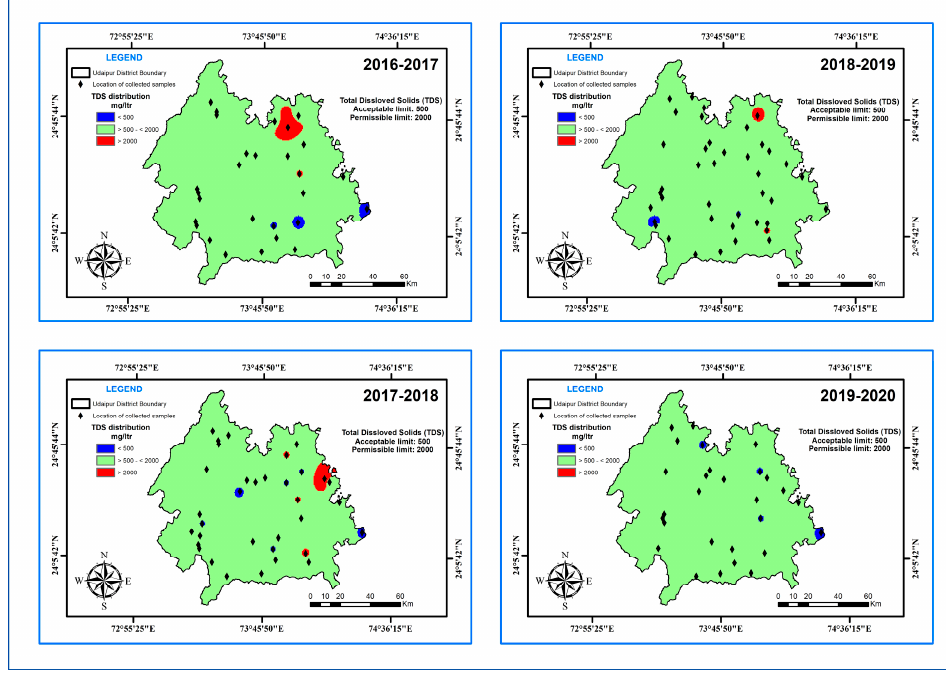
Figure 14. The changing distribution of TDS from 2016–2018 in the study area.